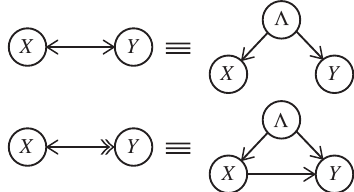
FIG. 4. Shortcut graphical notations for causal connections between X and Y .